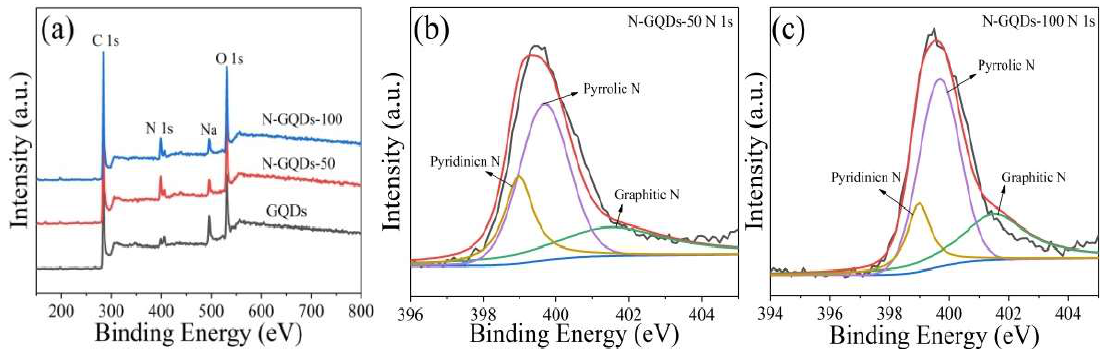
Figure 3. The full XPS spectra ( a ) of GQDs, N-GQDs-50 and N-GQDs-100. High-resolution N 1s Table 1. The atomic percent (%) GQDs, N-GQDs-50 and N-GQDs-100 from XPS data. Samples C (at%) O (at%) N (at%)